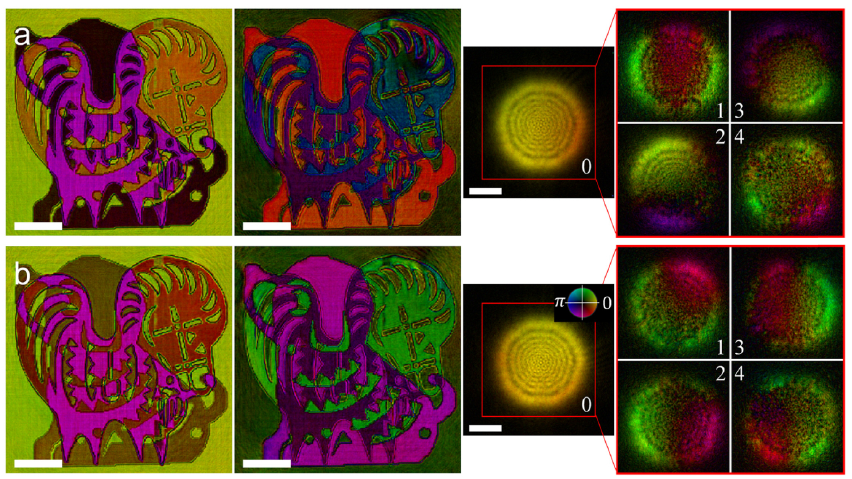
Figure 2. Two different sets of reconstructions from the same data set using different initial guesses. ( a ) The first set of raw reconstructions; ( b ) The second set of raw reconstructions. The scale bars indicate a length of 300 m. The color wheel applies to all the images. To aid in display, the curvature of the probe phases has been removed. Figure adapted from [10], Reprint permission granted, 2016 The Optical